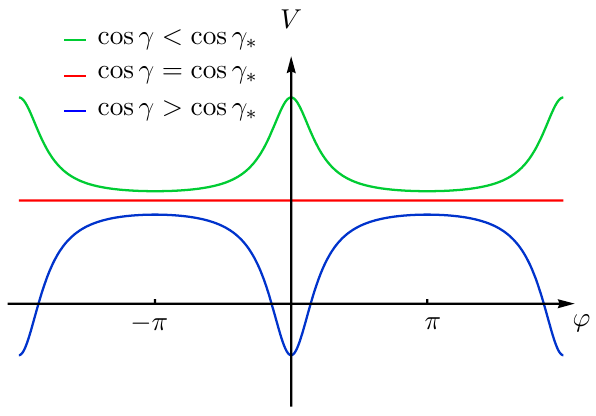
Figure 4 . Form of the Schr(cid:127)odinger potential for di(cid:11)erent relations between cos (cid:13) and cos (cid:13) (cid:3) . The value of ’ min shifts from 0 to (cid:25) depending on the aforementioned